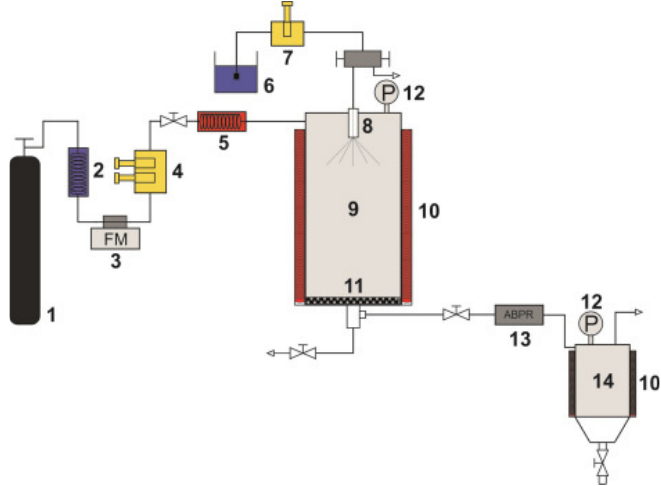
Figure 5. Schematic representation of a set-up for the preparation of oxides using scCO 2 as anti-solvent: (1) CO 2 tank; (2) CO 2 cooler; (3) CO mass flowmeter; (4) CO 2 high-pressure pump; (5) CO 2 pre-heater, (6) precursor solution, (7) high-pressure precursor solution; (8) nozzle; (9) precipitation vessel; (10) heating jacket; (11) metal filter; (12) manometer; (13) automatic back-pressure regulator; (14) separator. (Reprinted with permission from [48]. Copyright Elsevier, 2016).